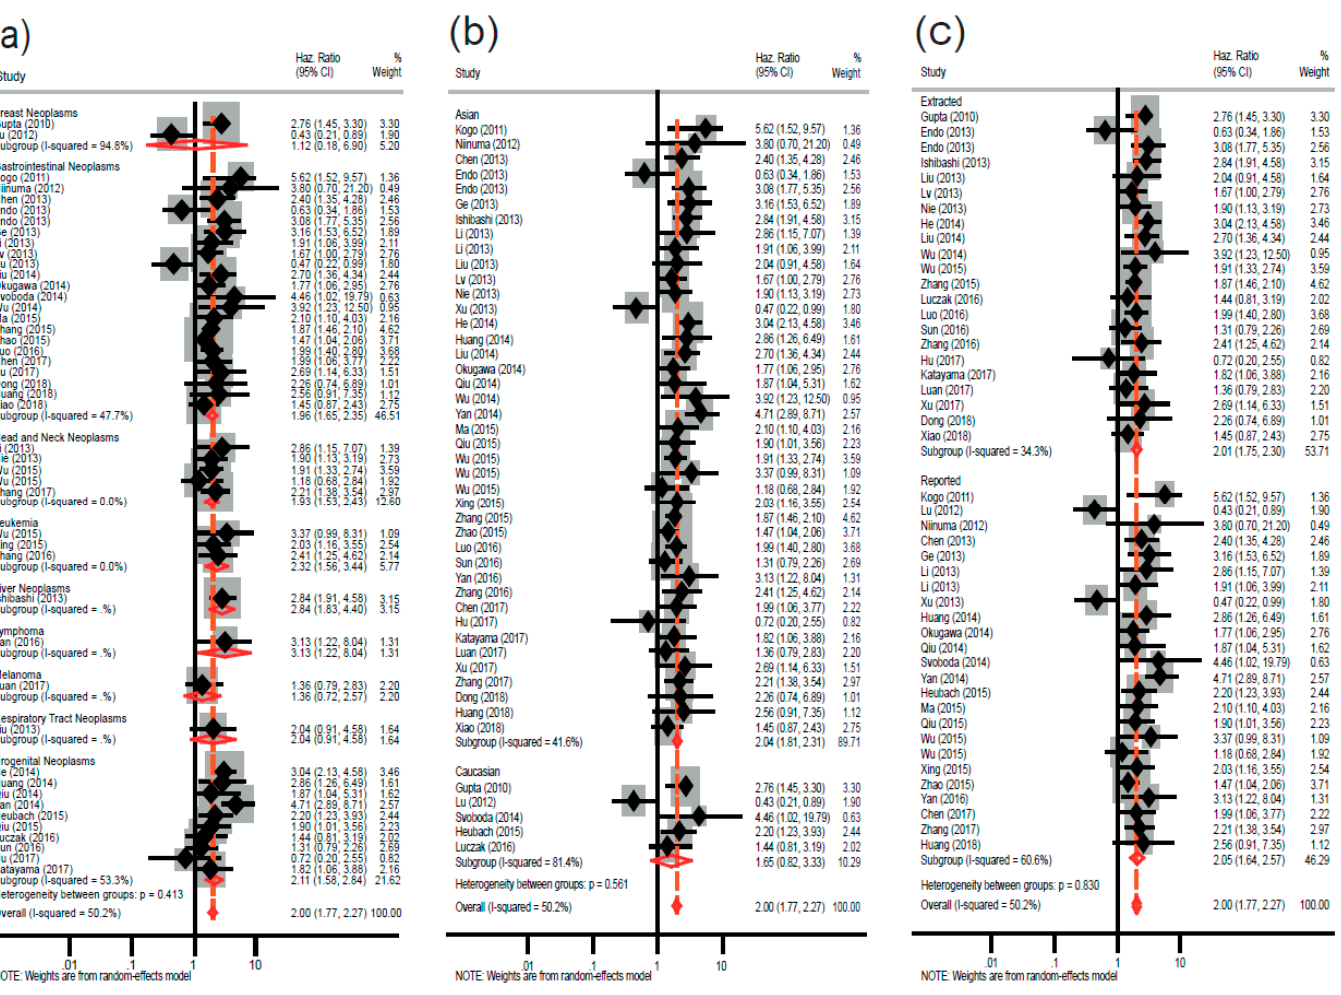
Figure 3. Forest plots of combined analyses for overall survival (OS) associated with HOTAIR expression in different groups. ( a ) Forest plot for different types of cancers, ( b ) forest plot for different ethnic groups, and ( c ) forest plot for different data extraction methods.